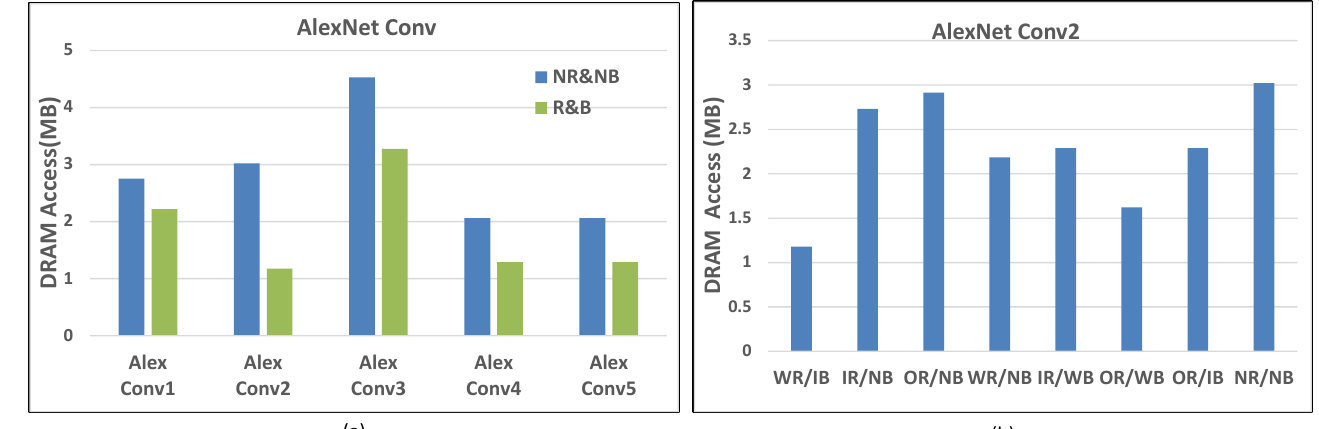
Figure 13. The DRAM access of convolution layers of AlexNet. ( a ) AlexNet Conv1-5 . ( b ) AlexNet Conv2.